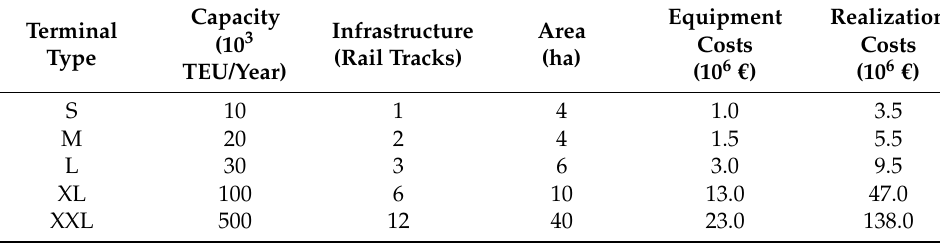
Table 2. Costs of intermodal rail terminals.